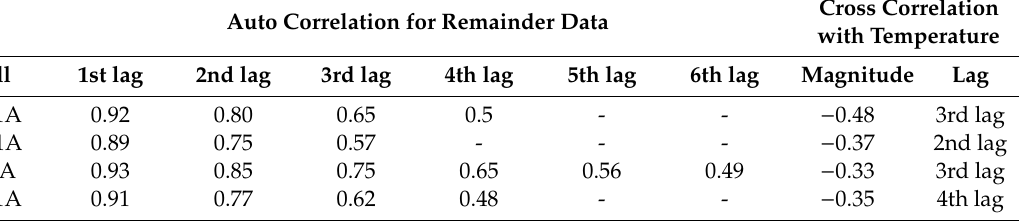
Table 2. Auto- and cross correlations for groundwater remainder data. Auto Correlation for Remainder Data